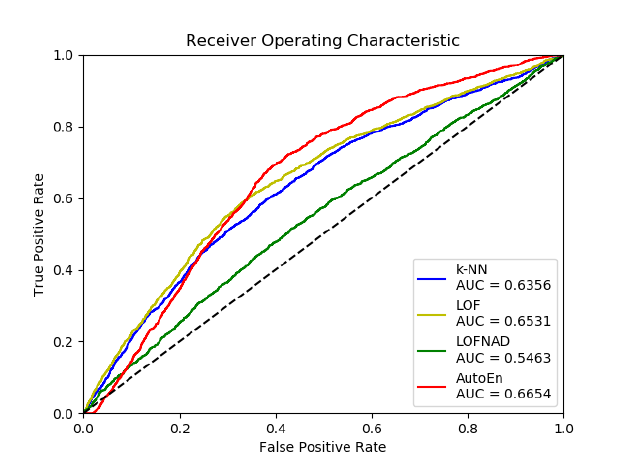
Figure 7. The ROCs and the AUC values.